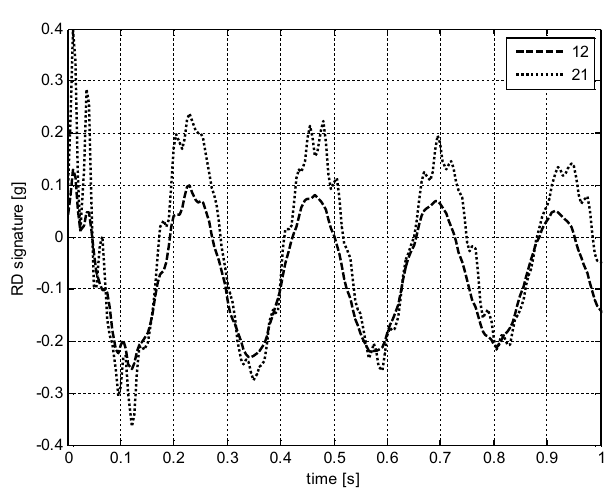
Fig. 11. Comparison of RD signatures 12 and 21 of experimental